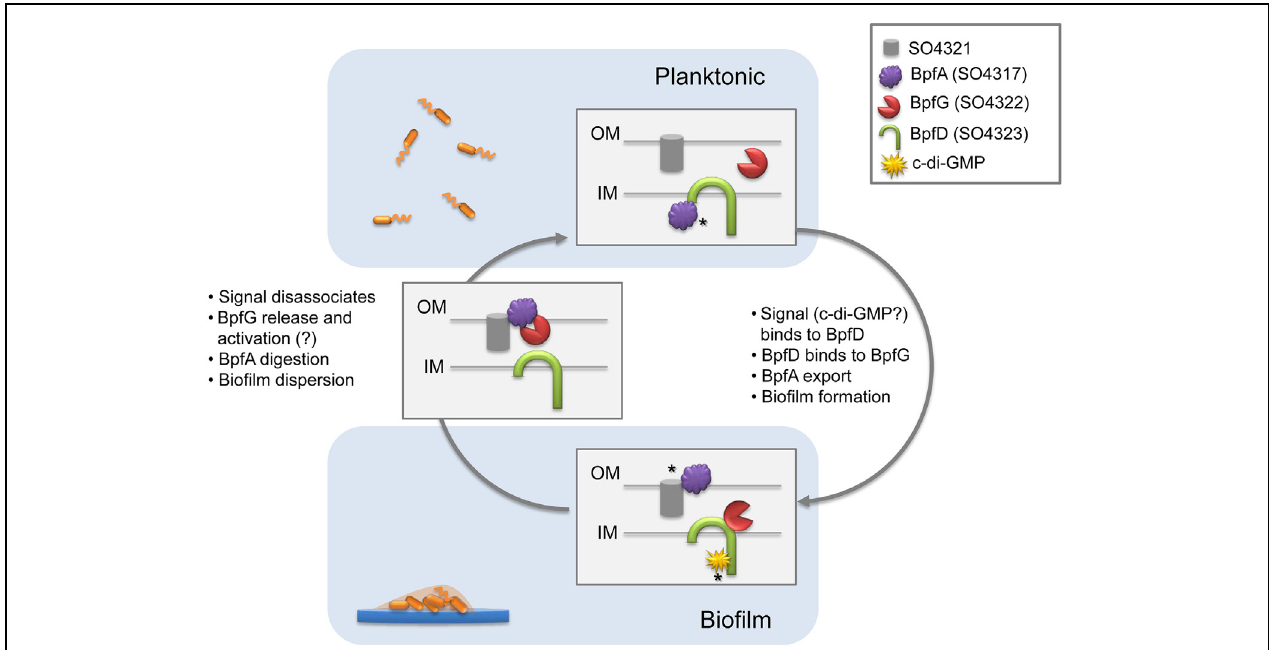
FIGURE 6 | Proposed model for regulatory biofilm formation mechanism in S. oneidensis MR-1. In planktonic cells, BpfA is captured by BpfD to prevent biofilm formation. In biofilm forming stage, c-di-GMP and BpfG bind to BpfD, resulting in BpfA release and export by TISS system (not shown in figure). SO4321 facilitates BpfA localization on the outer